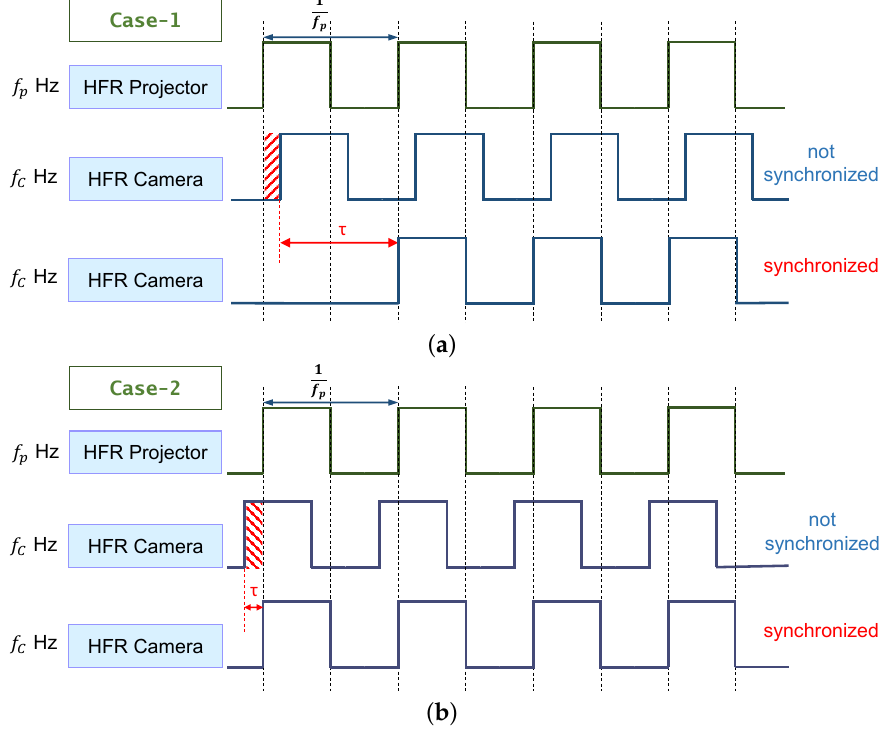
Figure 6. Timing control of synchronization error: ( a ) case-1 and ( b )